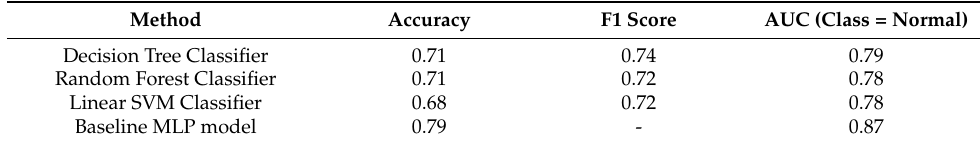
Table 4. Baseline models performance.